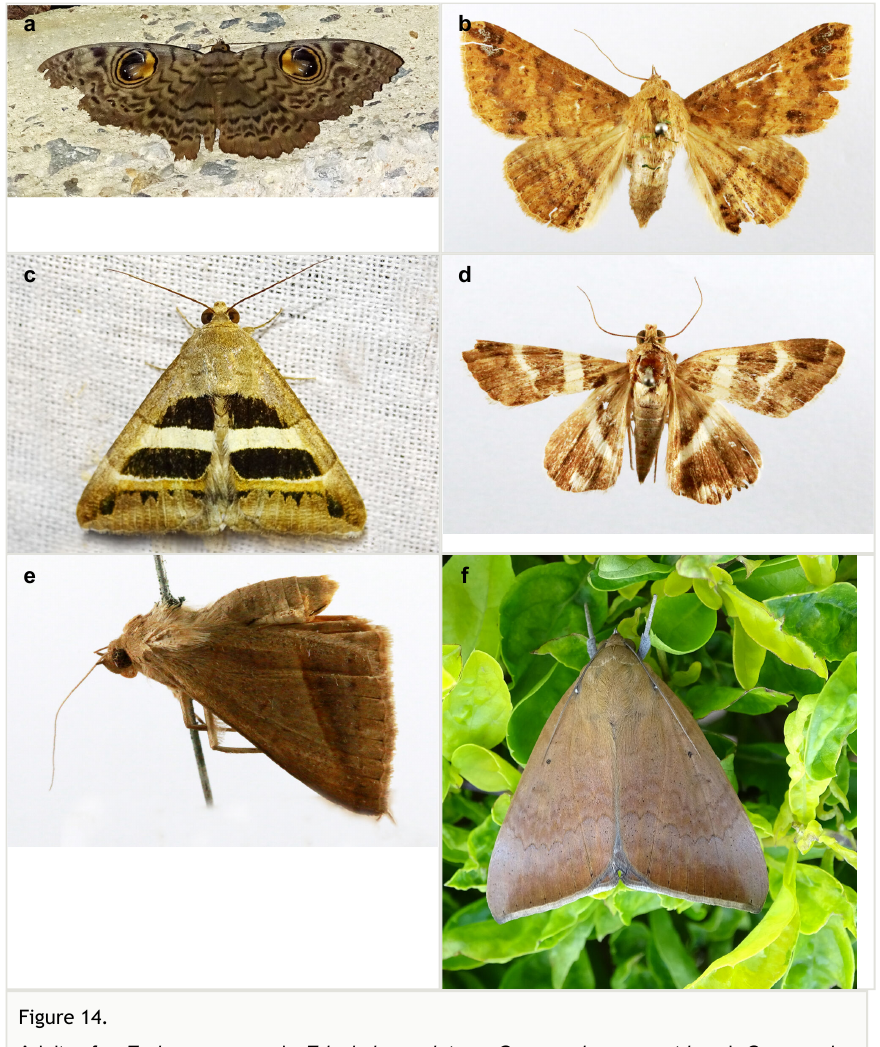
Adults of a. Erebus macrops ; b. Ericeia inangulata ; c. Grammodes geometrica ; d. Grammodes stolida ; e. Mocis frugalis ; f. Ophisma